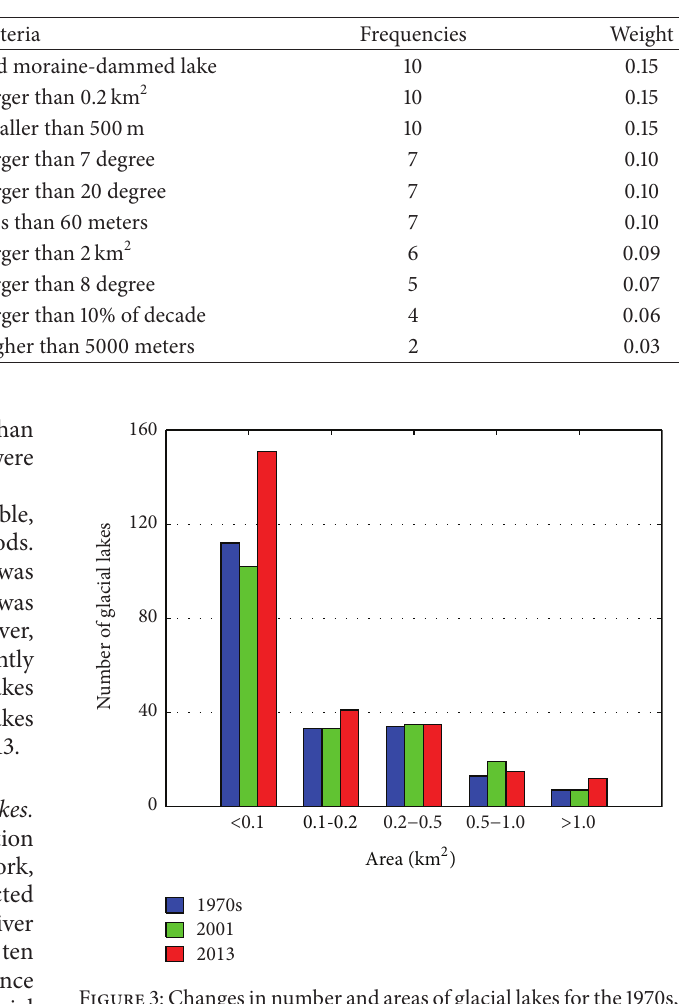
Table 3: Integrated criteria for identifying potentially dangerous glacial lakes.